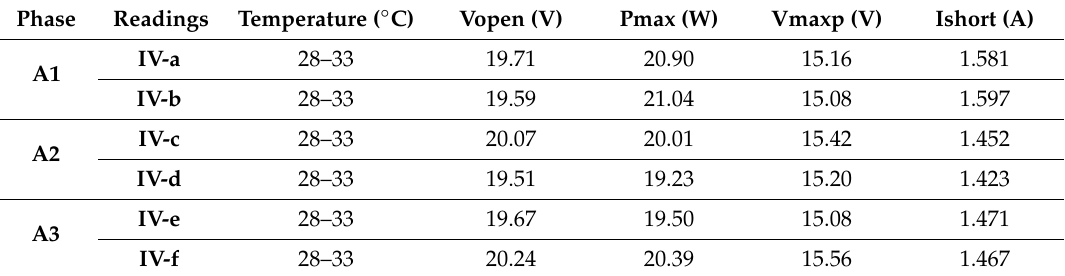
Figure 4. Tripartite analysis of the electrical performance of the developed module: ( a – d ) random readings depicting the relationships between variables; Vopen-(V), Ishort-(A) and Pmax-(W). Table 1. A summary of verified achievements of three evaluation phases of the developed